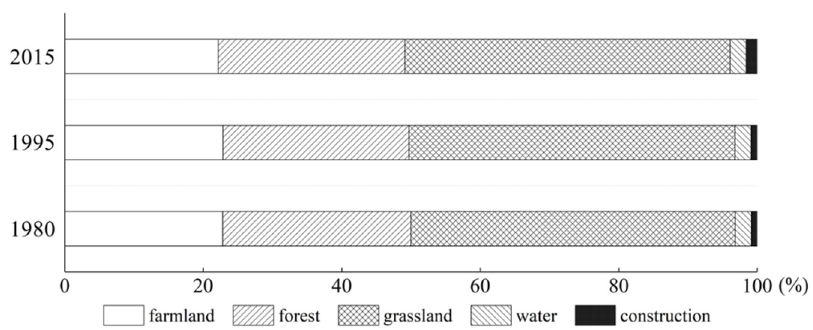
Figure 7. The proportion of land use in the upper Tang River catchment (%).